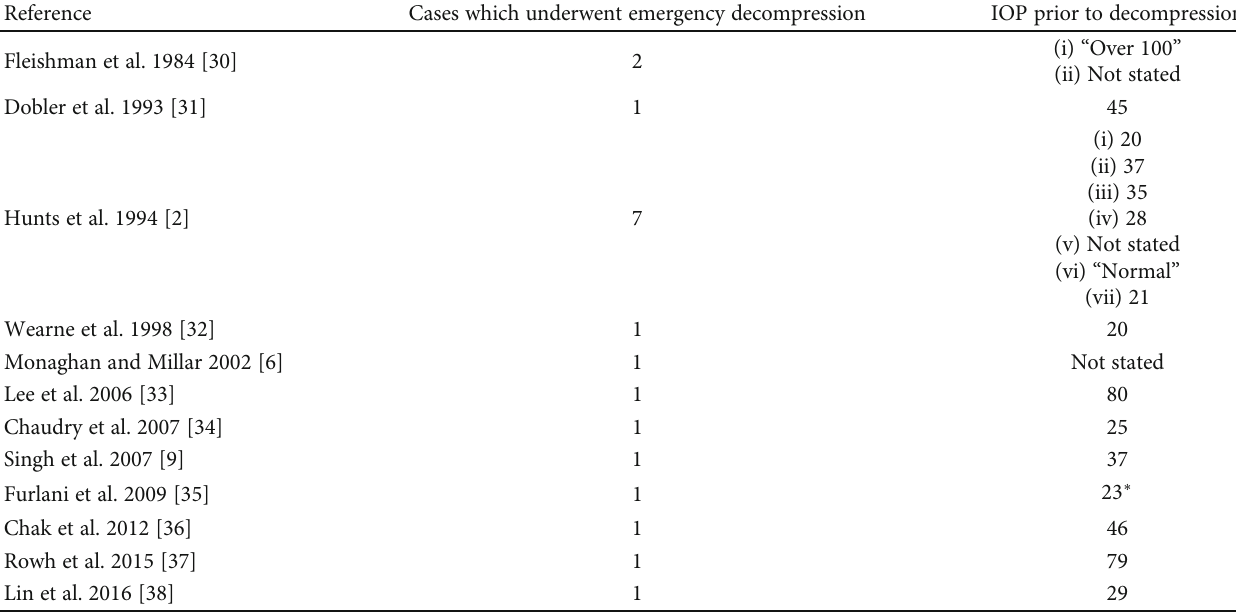
Table 1: Intraocular pressure in cases of orbital emphysema in which patients underwent emergency decompression.